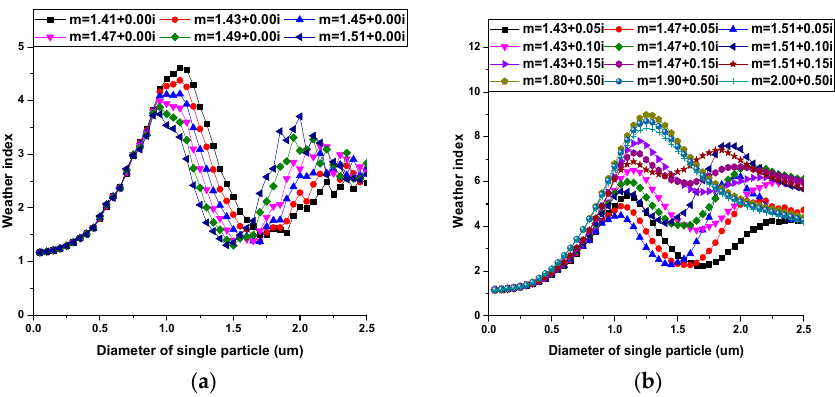
Figure 5. Relationship between the diameter of single particle and the weather index: ( a ) non-absorbing particles; ( b ) absorbing particles.